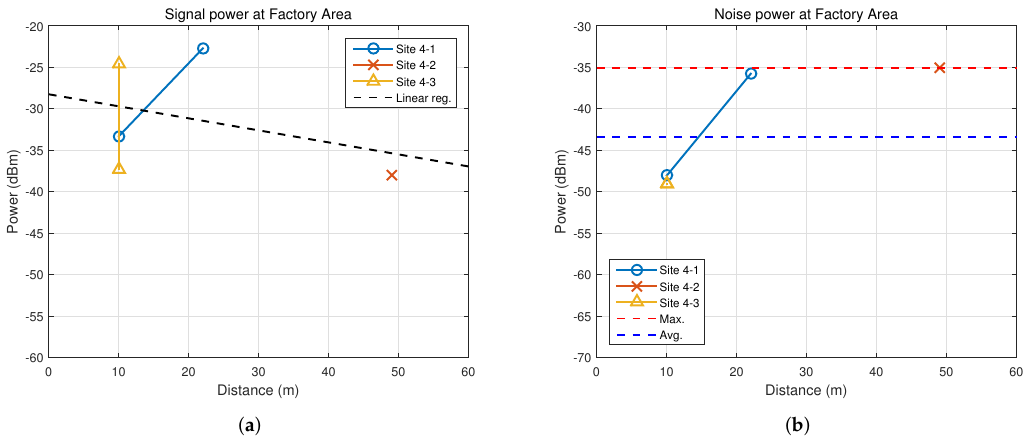
Figure 23. Overhead Factory Area. ( a ) Received power. ( b ) Noise power.